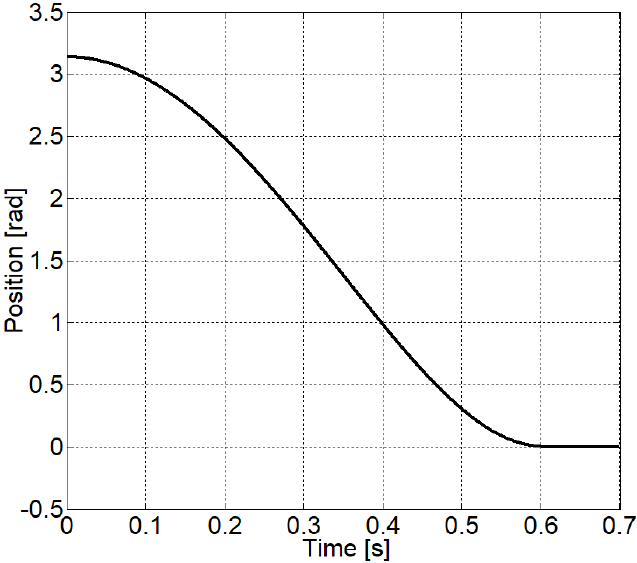
Figure 11. System’s position with both input and velocity constraints.